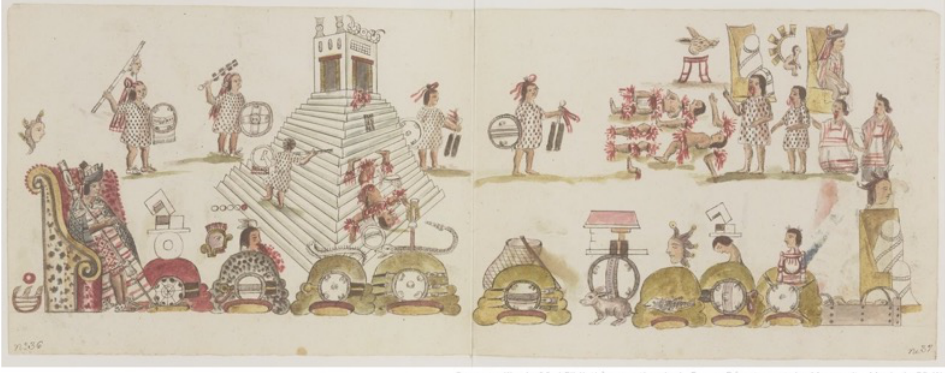
Cuacuapitzauac, the first ruler of Tlatelolco, and Acamapichtli, the first ruler of Tenochtitlan. Thus, in addition to the theme of migration, Codex Azcatitlan depicts imperial history and the founding of the major Mexica cities. It also portrays the 1519 arrival of Hernán Cortés and his troops to Mexico City and the ensuing battle in 1521, ending in 1527. 27